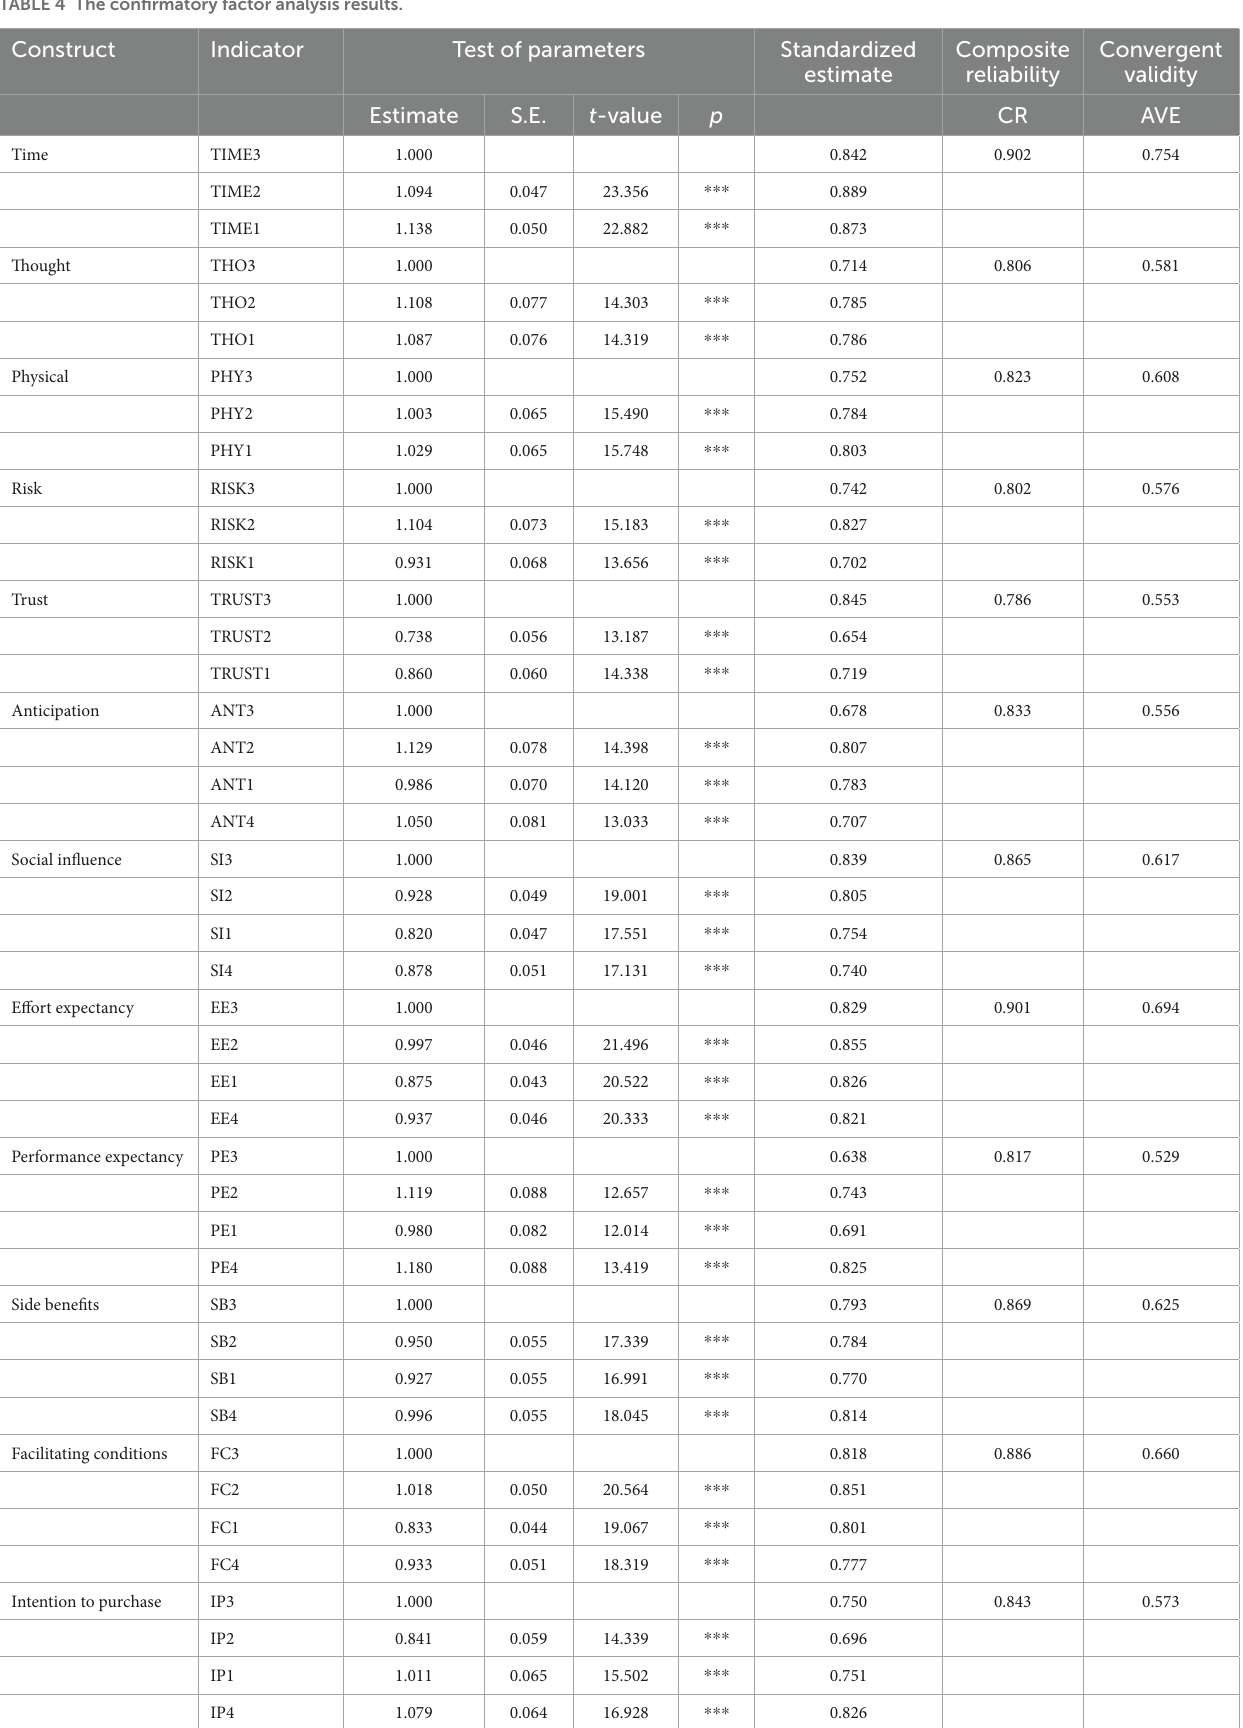
TABLE 4 The confirmatory factor analysis results.